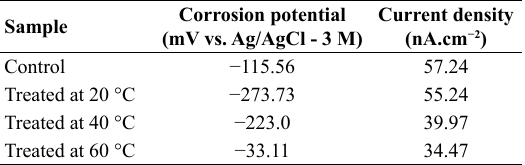
Table 3. Potentiodynamic polarization curve data of samples. Sample